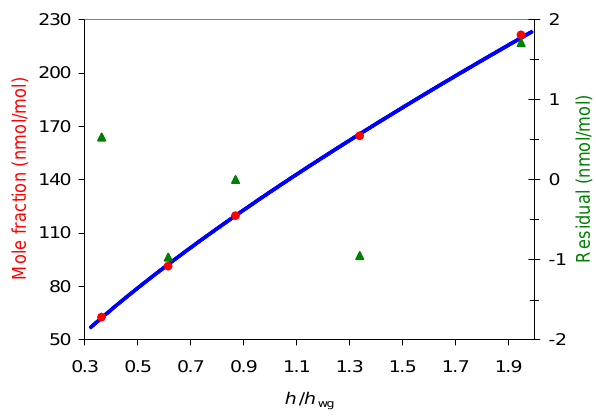
Fig. 2. Least-squares fitting of a typical calibration. The fitting curve is plotted in blue (left y-axis), the measured means are plotted in red (left y-axis), whereas the residuals with respect to the fitting curve are plotted in green (right